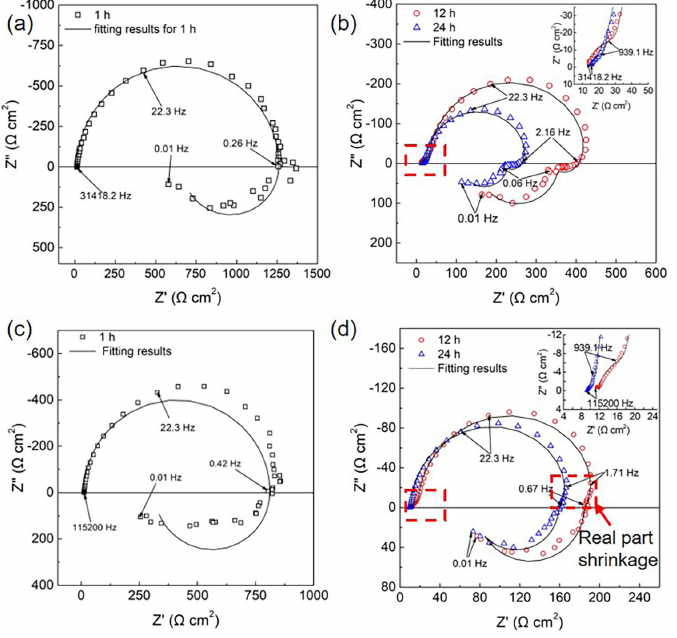
Figure 2. Nyquist plots in 0.9 wt.% NaCl solution: ( a , b ) the HOMO samples and ( c , d ) the LPSO samples. In ( b , d ), the enlargement of high-frequency parts was presented at the top left